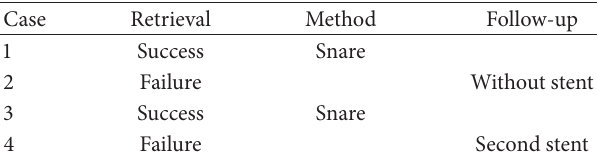
Table 10: Stents retrieval of fractured cases.